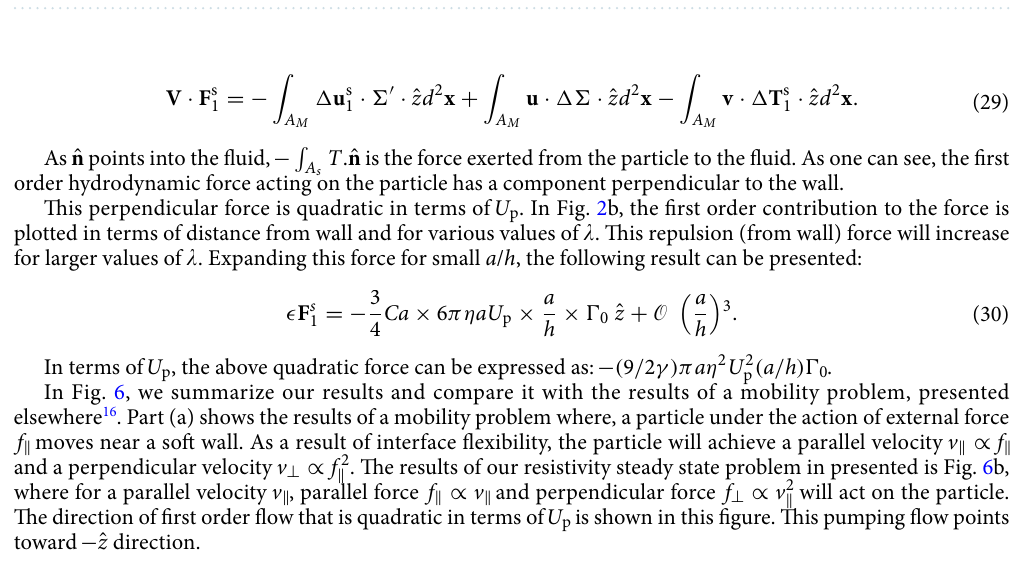
Figure 6. ( a ): A mobility problem where a particle under the action of an external force f wall. This particle experiences both parallel and perpendicular motions with corresponding speeds proportional to f and f 2 , respectively. This will eventually form a repelling trajectory (from the wall) for the particle. ( b ): (cid:31) (cid:31) Our resistivity problem where, a particle is constraint to move parallel to a soft wall with a given velocity v hydrodynamic force acting on this particle will have both parallel and perpendicular components proportional to v and v 2 , respectively. In this resistivity problem, to keep a fixed distance from the wall, we should apply an (cid:31) (cid:31) external force that is perpendicular to the wall with f e is a result of a repelling (pumping) flow that is back scattered from the wall. Pumping flow that is the nonlinear part of the velocity profile (first order flow) is shown in this